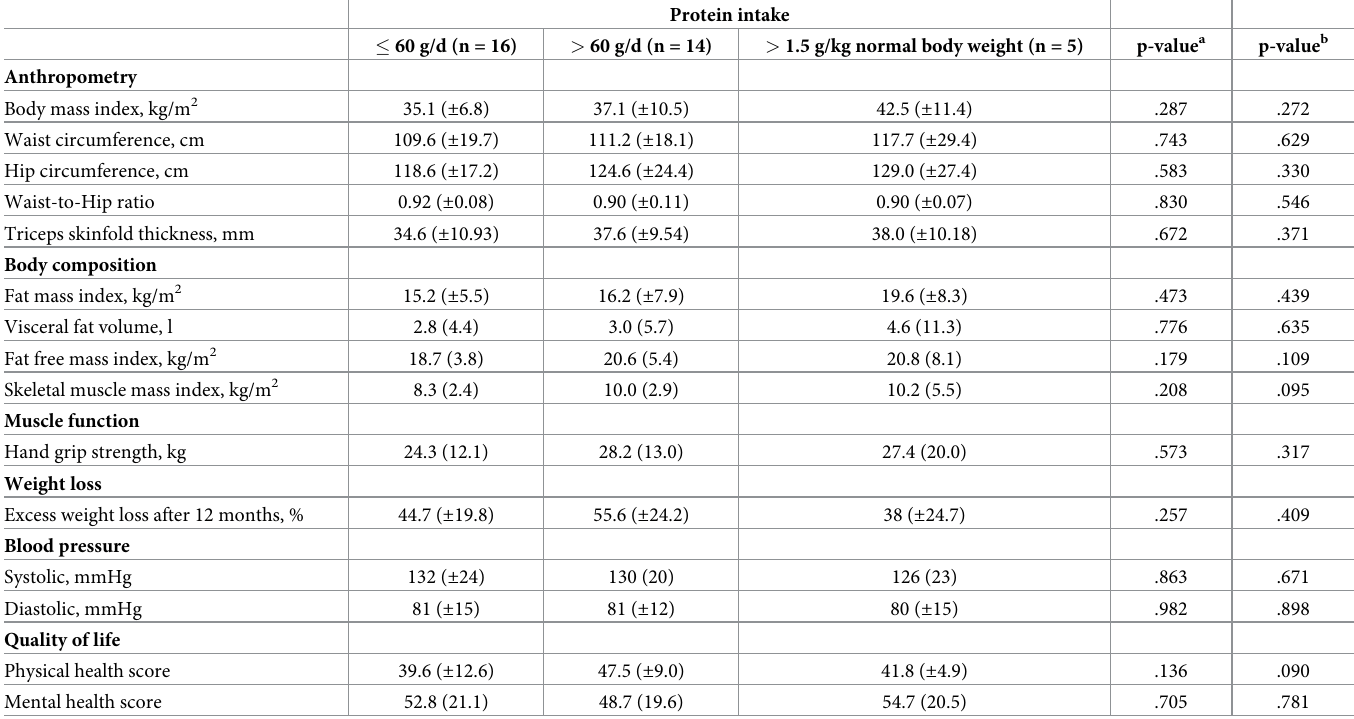
Table 3. Outcome parameters by adherence to the German S3 guideline recommendations on protein intake.